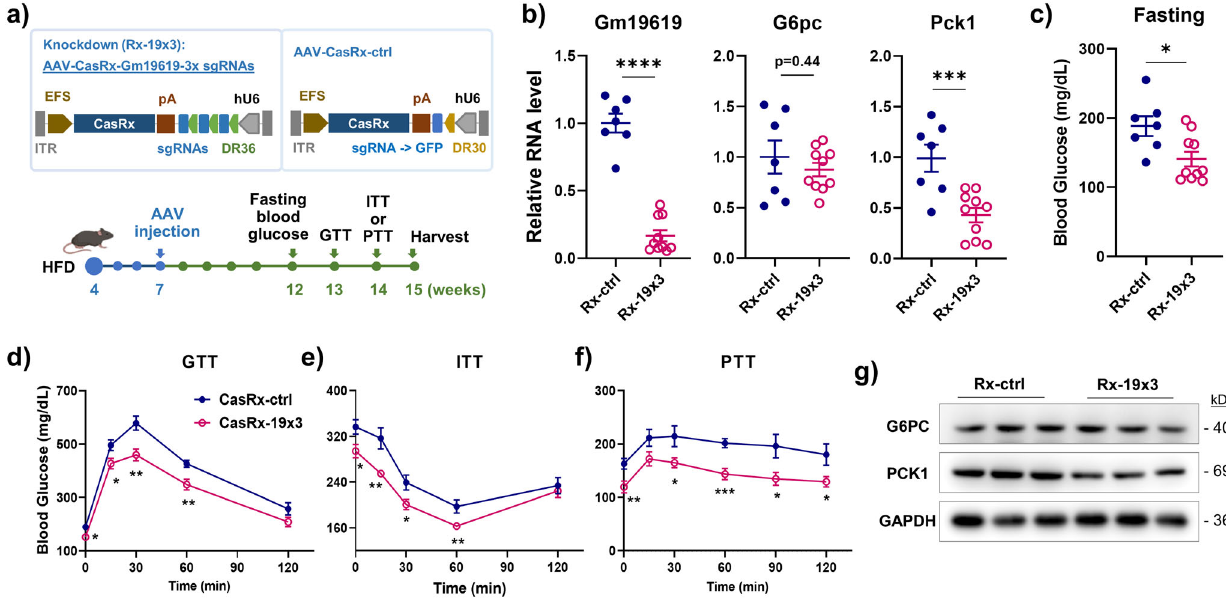
Fig. 3 AAV-CasRx mediated Gm19619 knockdown in high-fat diet (HFD) fed mice signi fi cantly improved the mice glucose metabolism. a Schema of the AAV-EFS-CasRx vector for Gm19619 knockdown and the experimental timeline. b The relative RNA levels of hepatic Gm19619, G6pc , and Pck1 in Gm19619 knockdown (CasRx-19×3) ( n = 10) and control (CasRx-ctrl) ( n = 7) mice. c The fasting blood glucose levels in CasRx-19×3 mice ( n = 10) and CasRx-ctrl ( n = 7) mice. d – f The GTT ( d ), ITT ( e ), and PTT ( f ) assay of CasRx-19×3 ( n = 10, PTT n = 8) and CasRx-ctrl ( n = 7) mice. g The western blot results of G6PC and PCK1 in CasRx-19×3 and control group mice livers ( n = 3). Two-tailed unpaired t -test. Error bars represent the SEM. * P < 0.05, ** P < 0.01, and *** P < 0.001.